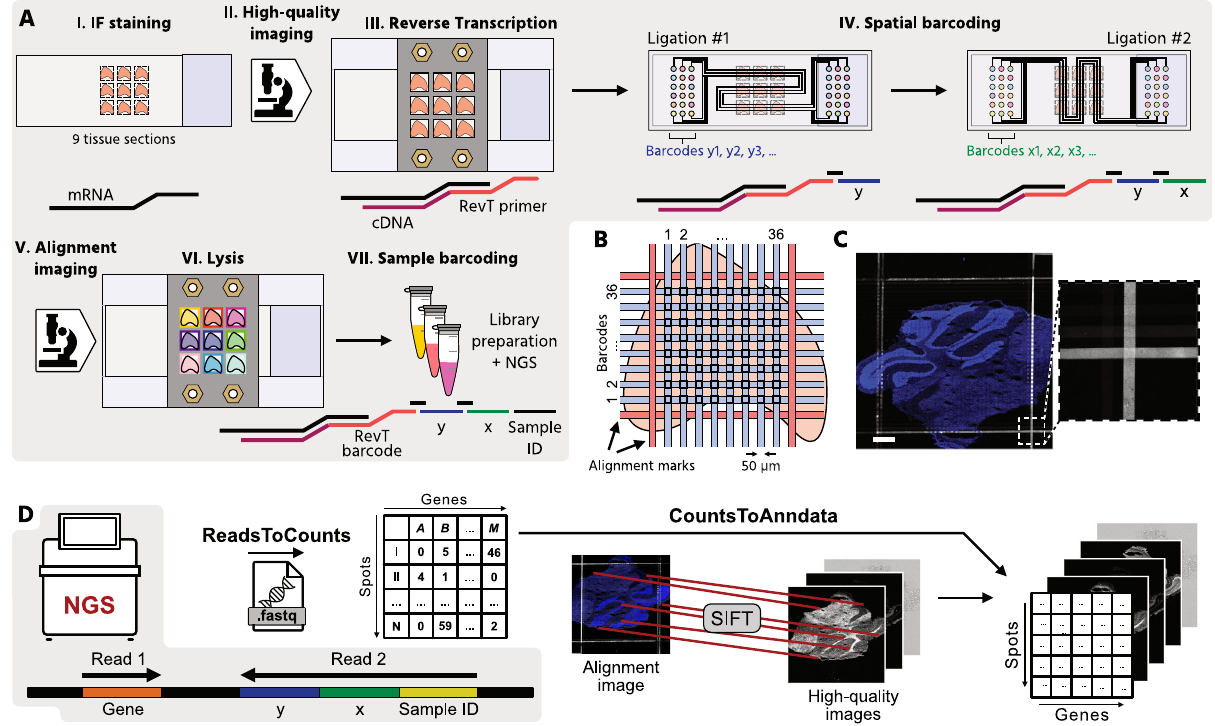
Fig. 1 | Multiplexed deterministic barcoding in tissue (xDBiT). A Work fl ow of xDBiT: (I) Deposition of PFA- fi xed cryosections with a thickness of 10 µ m onto a glasssubstrateina3×3matrixlayoutandIFstaining.(II)Acquisitionofhigh-quality fl uorescence images. (III) Reverse transcription of mRNA into cDNA in all